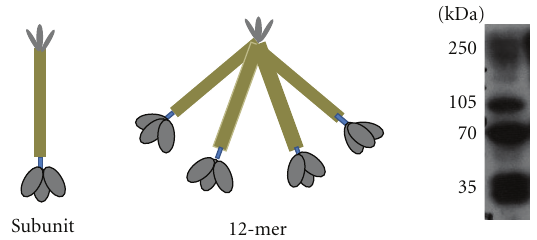
Figure 2: L-ficolin structure. The glycosylated gene product of Mr 35K forms a basic triplet subunit. The subunit can form higher multimers, of which the 12-mer (4 × 3) is thought to be the most abundant in serum. The inset (right) shows a typical western blot after electrophoresis of L-ficolin under nonreducing